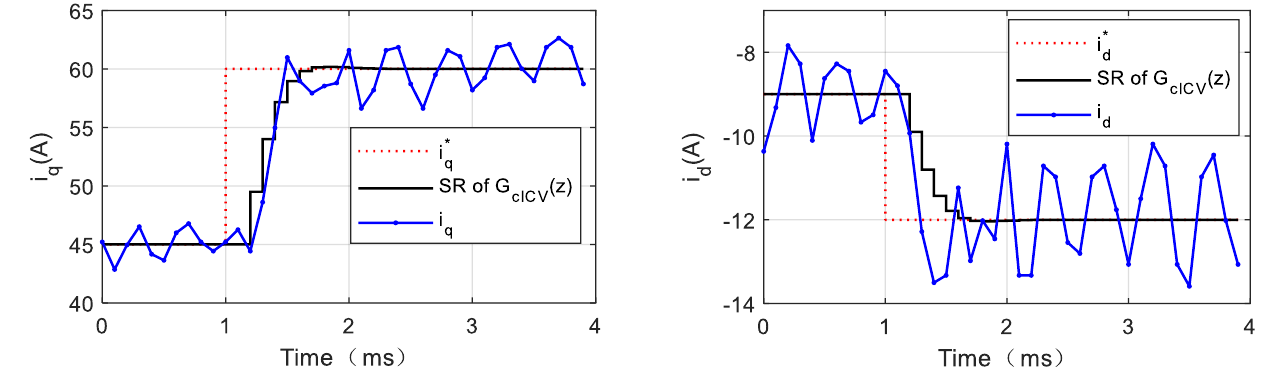
Figure 21. Experiment result of complex vector controller based on flux-linkage data ( k = 0.3, f s = 10 kHz) of the high-speed saturated machine ( f out = 833